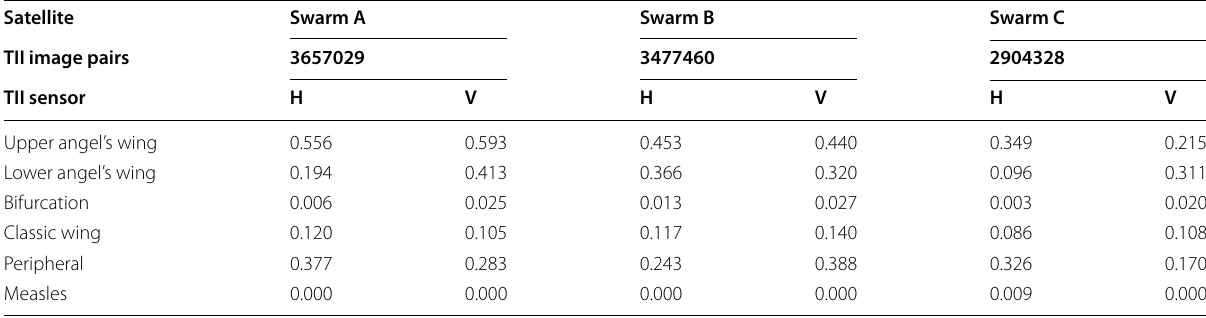
Table 4 TII imaging anomaly occurrence probabilities from analysis of full images obtained during science operations Satellite Swarm A Swarm B Swarm C TII image